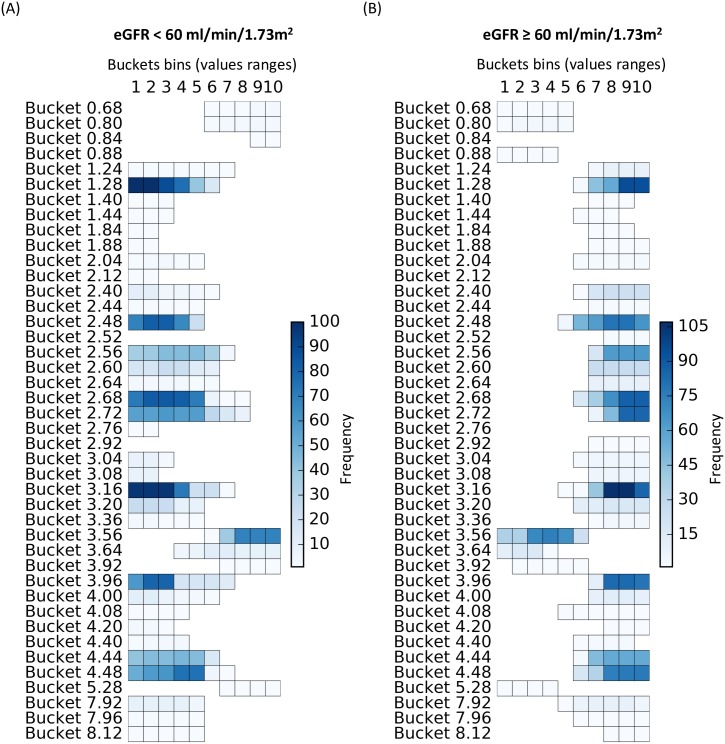
Buckets’ frequency over the 100 metabolomic local 1D models.Each horizontal segment corresponds to a 1D rule characterized by its bucket’s name, covered values ranges (i.e., buckets bins which could be interpreted as relative concentration) and frequency (color scale). The more robust the rule is, the darker it will be. (A) shows the rules corresponding to the subgroup of patients with an eGFR <60 ml/min/1.73m2 and conversely, (B) shows the rules corresponding to the subgroup of patients with an eGFR ≥ 60 ml/min/1.73m2.